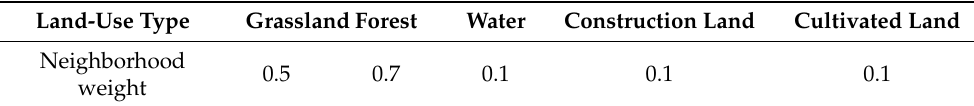
Table 3. Neighborhood weights for land-use types. Land-Use Type Grassland